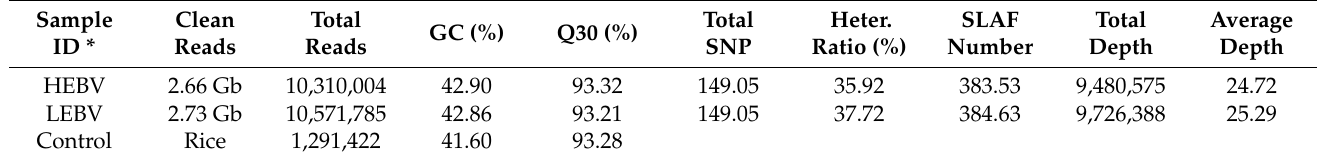
Table 1. Statistics of sequencing data for each sample.